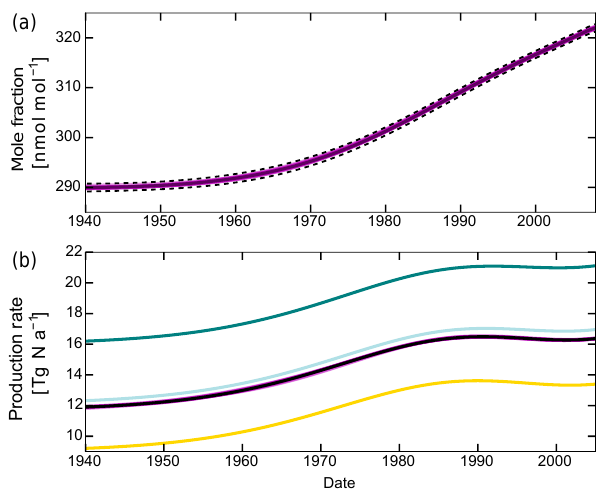
Figure D1. (a) N 2 O mole fraction history constrained with the most precise data at NEEM only to narrow the uncertainties (solid black line with uncertainty envelopes as dashed black lines) and the sce- narios within the uncertainty envelopes that were used in the mass balance model (magenta lines) to evaluate the uncertainties of the atmospheric modeling results. (b) N 2 O production rate as calcu- lated from the mass balance model assuming a change in the life- time from 123 years in 1700 to 119 years in 2008 (relative change similar to Prather et al., 2015) in light blue. The solid black line represents the result for the best-fit reconstruction, while magenta lines represent the results for the individual scenarios from the top panel (lifetime kept constant at 123 years) as used in the main pa- per. Light green and yellow show the results when the lifetime is 154 and 104 years, respectively.